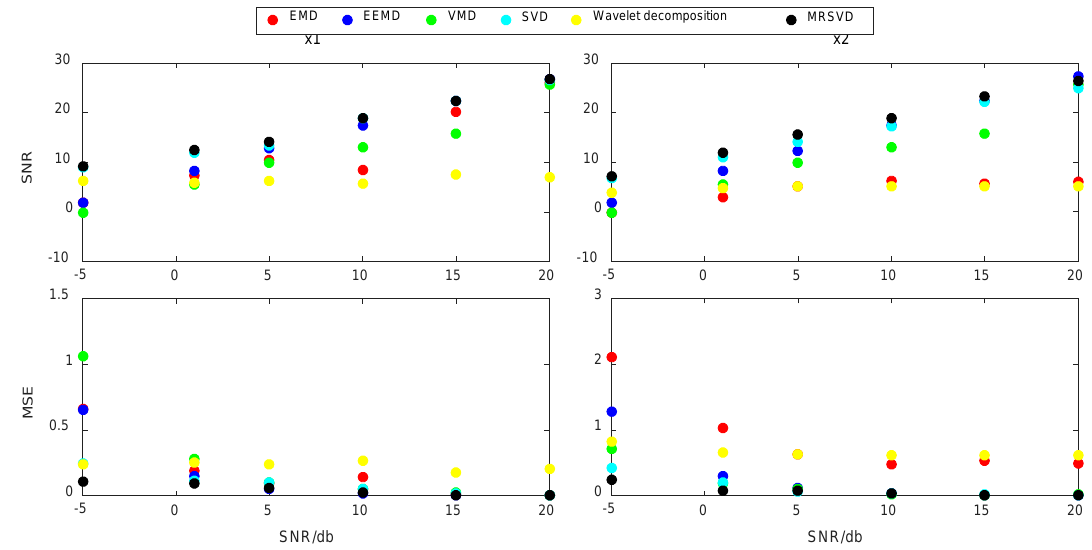
Figure 8. Index changes of various models under different noise powers.